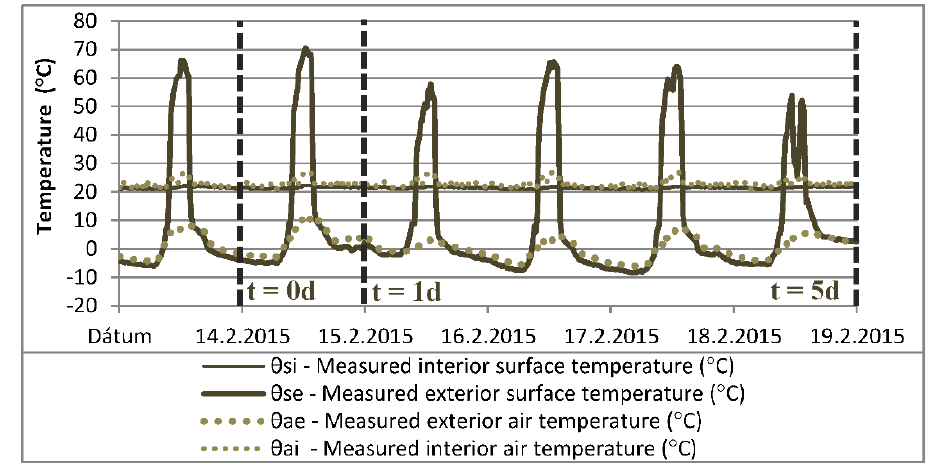
Figure 7. The measured temperature values of the interior and exterior surfaces for the analyzed interval (14 February 2015 to 19 February 2015).